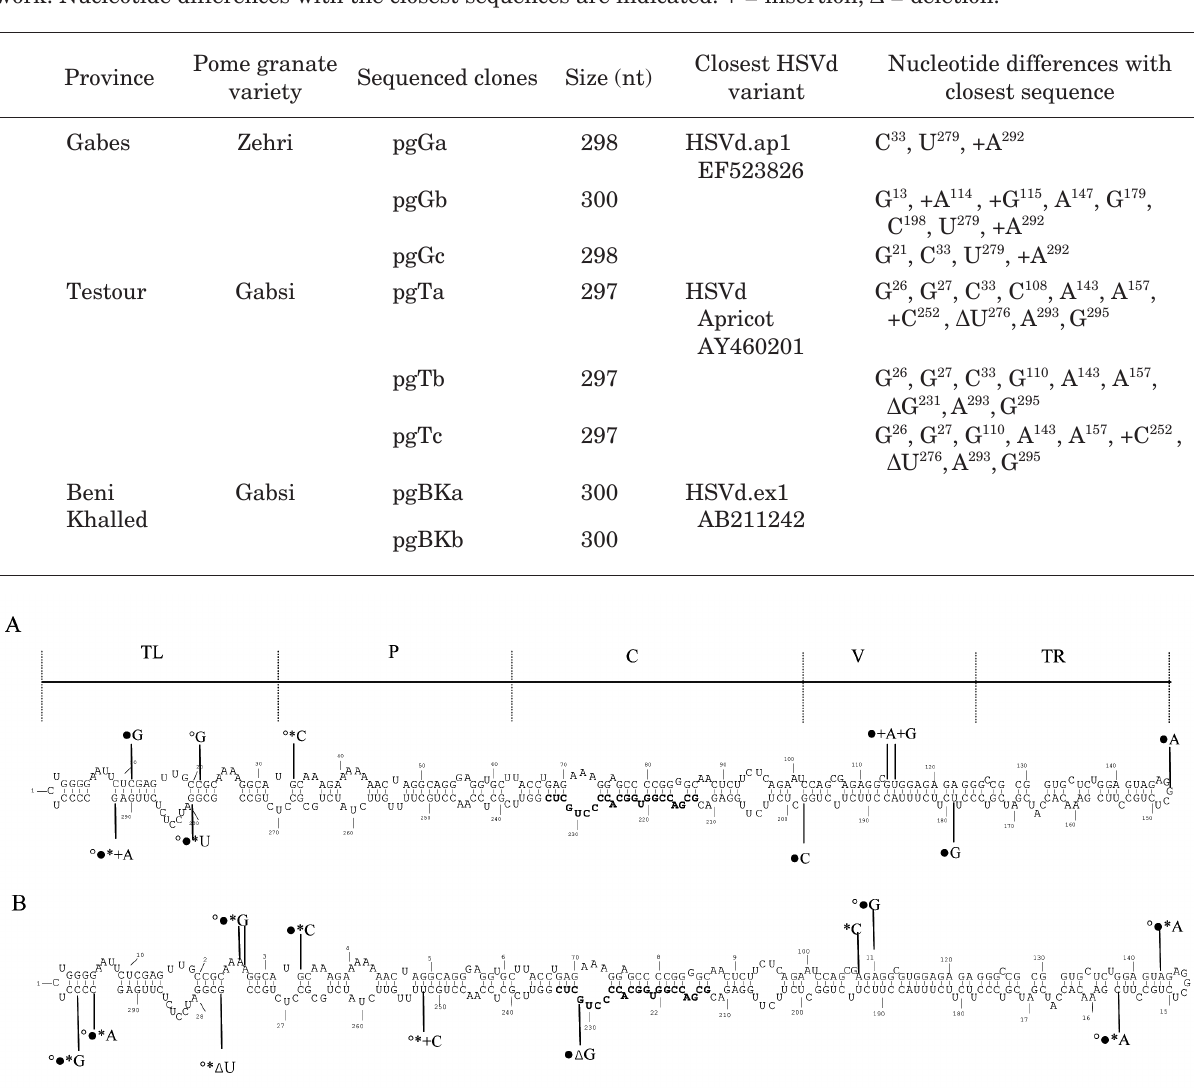
Table 2. The sources and sequence variants of Hop stunt viroid (HSVd) from Tunisian pomegranate analyzed in this